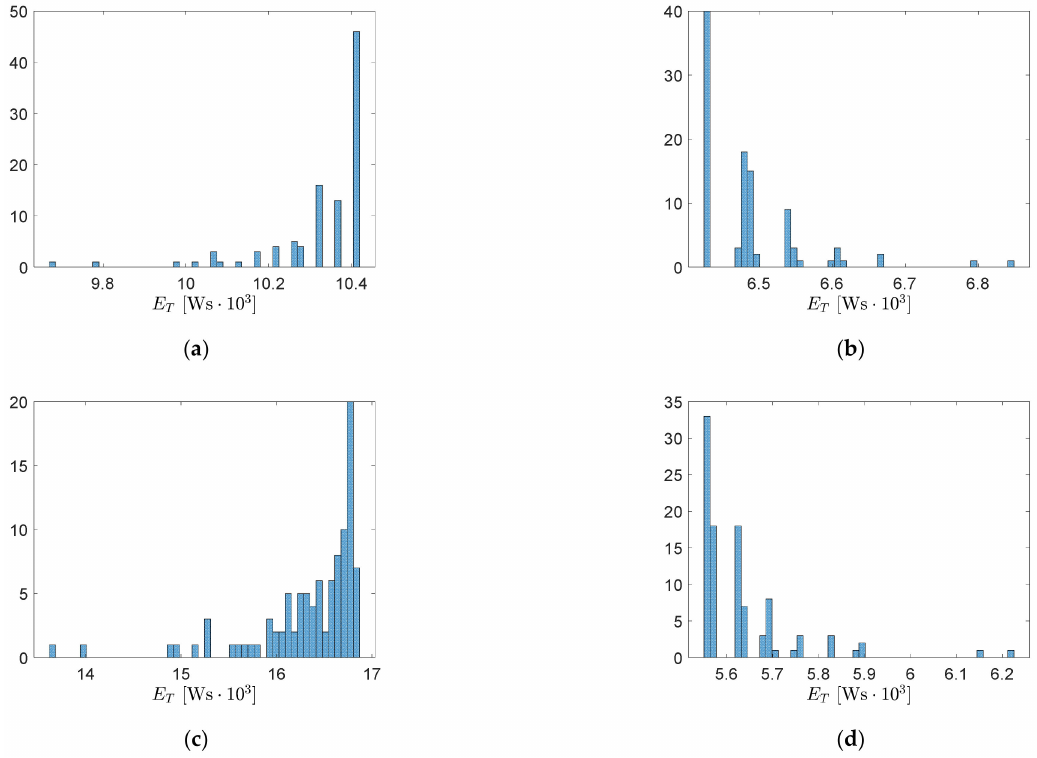
Figure 25. Histograms of consumed energy: ( a ) mean wind azimuth 0 ◦ , wind speed 4.5 m/s, ( b ) mean wind azimuth 180 ◦ , wind speed 4.5 m/s, ( c ) mean wind azimuth 0 ◦ , wind speed 9 m/s, and ( d ) mean wind azimuth 180 ◦ , wind speed 9